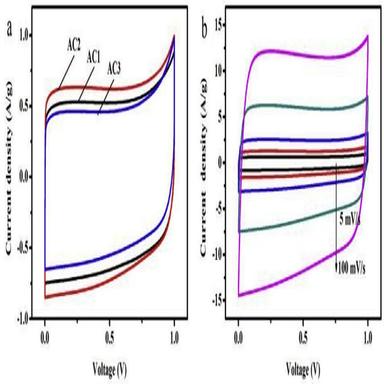
Cyclic voltammogram curves of (a) AC1, AC2 and AC3 at 5 mV/s and (b) AC2 at various scan rates.